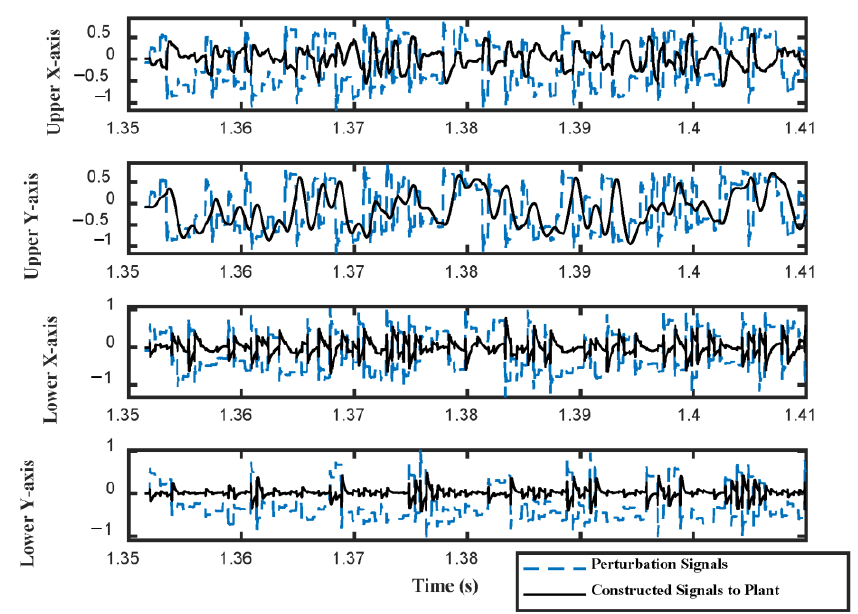
Figure 17. Constructed input signals applied to